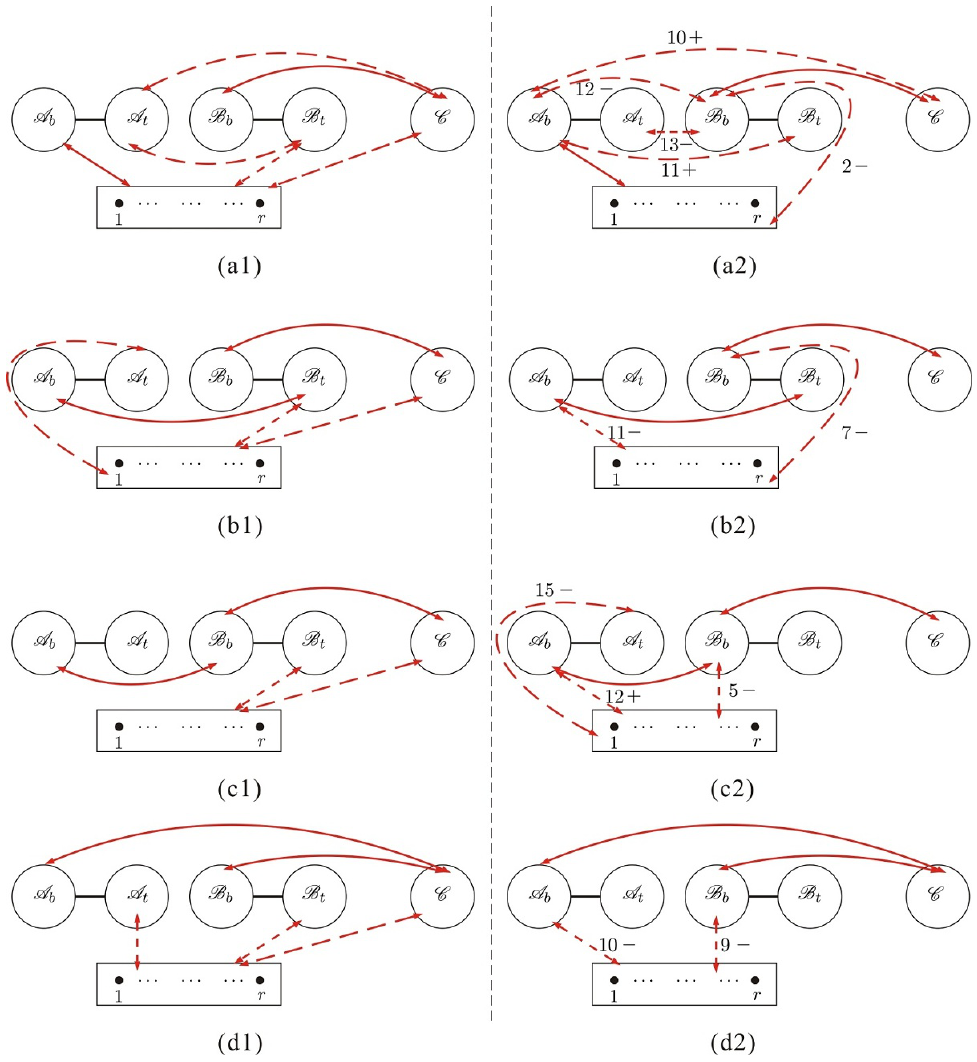
Figure 30 . Physical graphs (a1), (b1), (c1), (d1) for the skeleton (cid:12)gure 11 by construction-2 and the corresponding spurious graphs (a2), (b2), (c2), (d2): part 2.